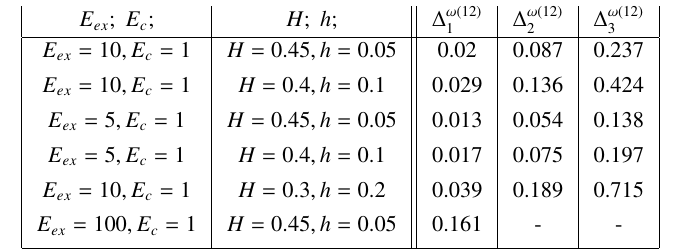
Table 2. Relative di ff erences for three-layer beam, ν = 0 . 25, ε = 1 /